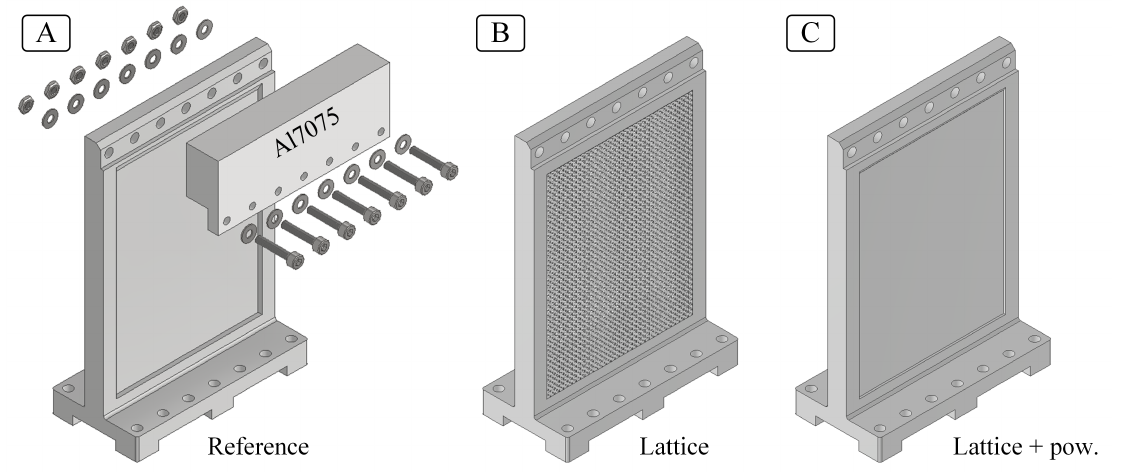
Figure 8. Blade like supports CAD models.